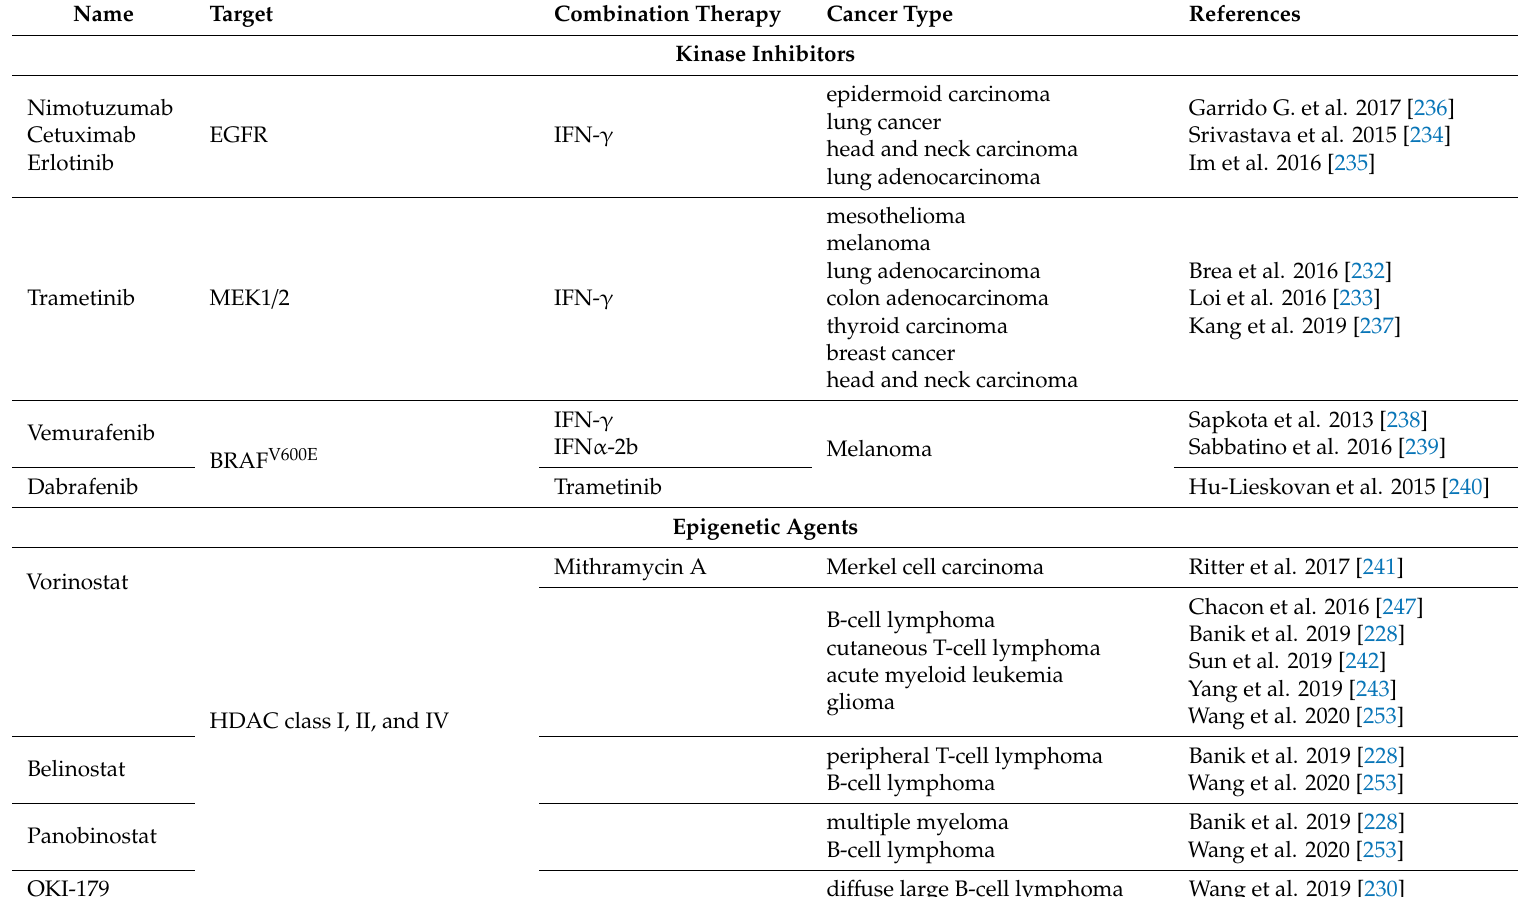
Table 1. Drugs for restoring MHC class I expression